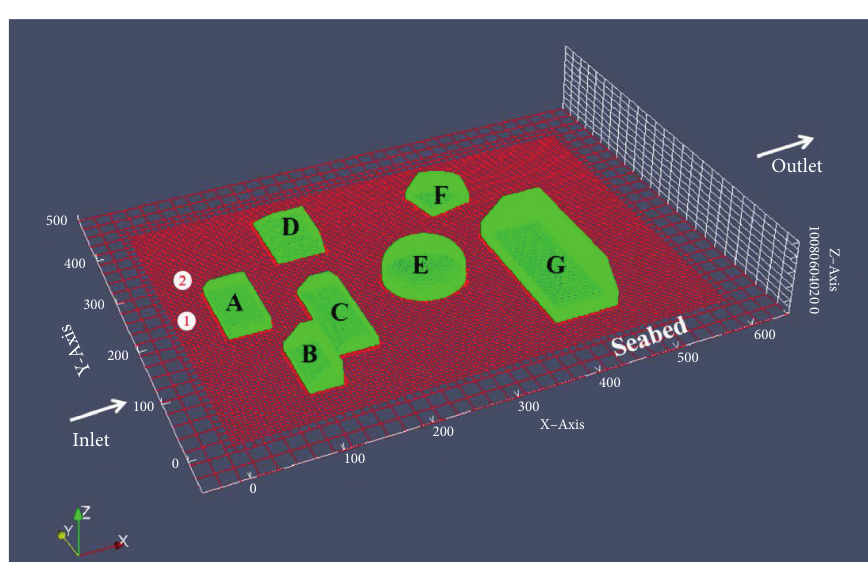
Figure 1: Sunken marine reactor on the seafloor with irregular reefs distribution.